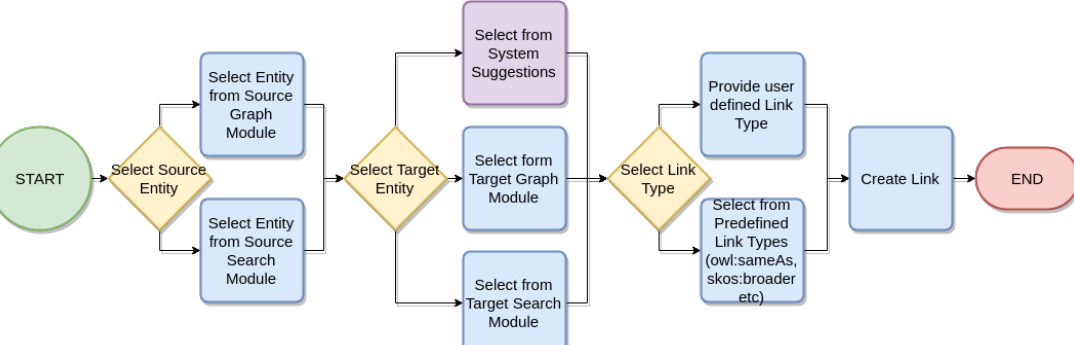
Figure 2. Link creation workflow.